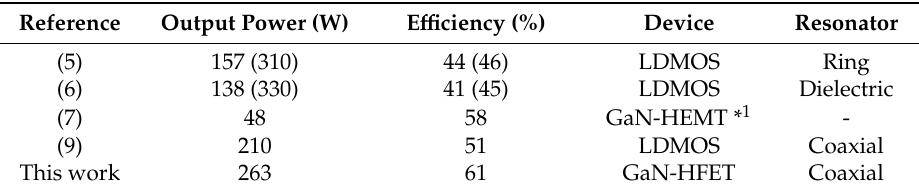
Table 1. Comparative analysis of the high power oscillators.